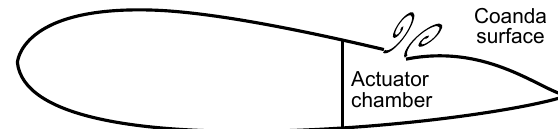
Figure 10. Schematic view of a blade with vortex generator jet and Coanda